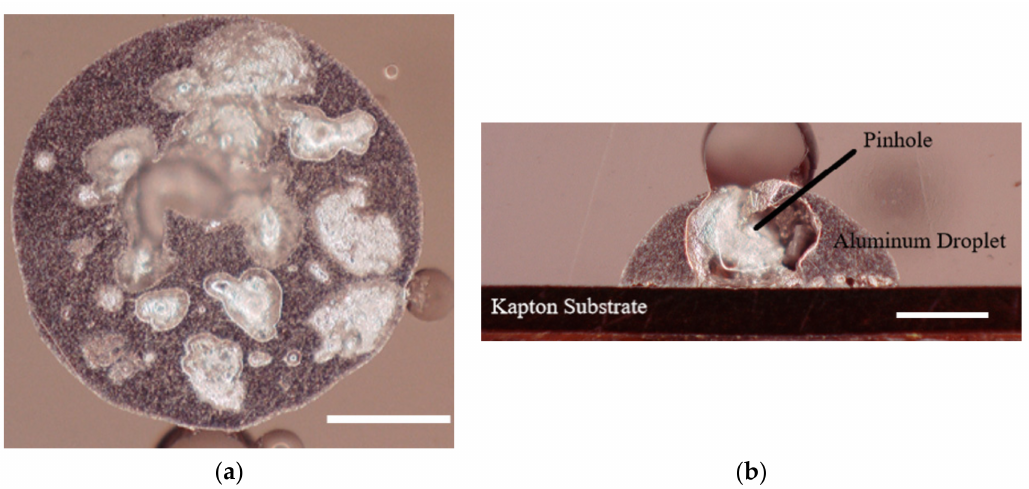
Figure 8. ( a ) Bottom view of a printed droplet and ( b ) side view of the droplet cross-section. Scale bar = 250 µ